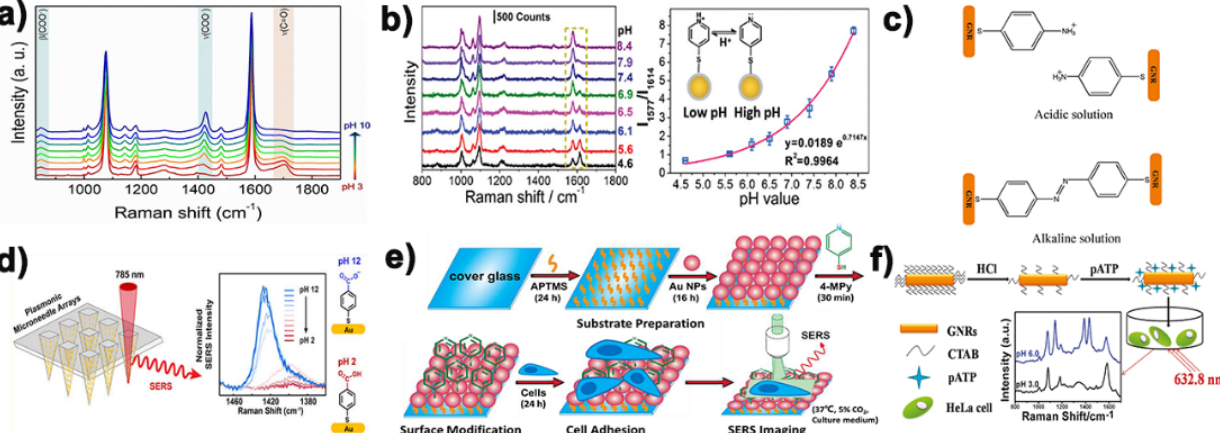
Figure 2. ( a ) Representative SERS spectrum of 4-MBA-AuNPs exposed to solutions at different pH values. Reprinted with permission from ref. [38]. Copyright 2019 Capocefalo, Mammucari, Brasili, Fasolato, Bordi, Postorino and Domenici. ( b ) Normalized SERS spectrum and pH standard curve of 4-Mpy functionalized pH nanosensors and changes of 4-Mpy molecular structure. Reprinted with permission from ref. [27]. Copyright 2019 Royal Society of Chemistry. ( c ) Schematic diagram of 4-ATP-GNRs structure in acidic and alkaline solutions. Reprinted with permission from ref. [19]. Copyright 2011 American Chemical Society. ( d ) 4-MBA modified plasma microneedle array pH response mechanism diagram. Reprinted with permission from ref. [25]. Copyright 2019 American Chemical Society. ( e ) Schematic diagram of 4-Mpy modified nanospheres array cell pH probe. Reprinted with permission from ref. [34]. Copyright 2018 American Chemical Society. ( f ) Flow chart of 4-ATP gold nanorods pH sensor preparation. Reprinted with permission from ref. [19]. Copyright 2011 American Chemical Society.